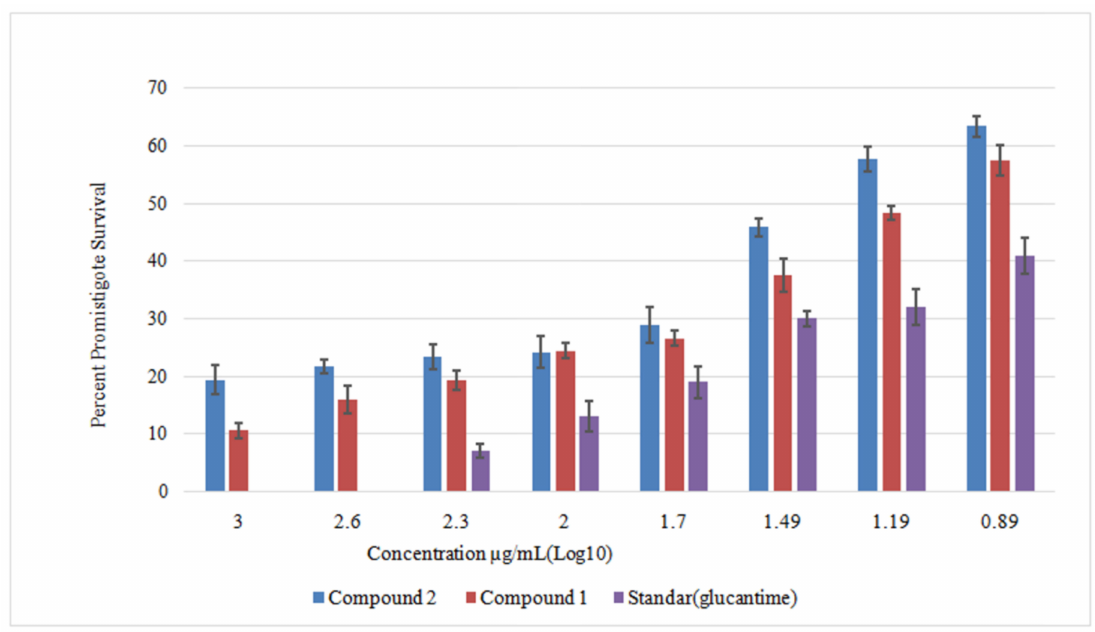
Figure 2. Anti-leishmanial potential of compound 1 and compound 2 in a dose-dependent assay, depicting promastigote survival after 72 h of treatment. Bars show significant di ff erence ( p < 0.05) in survival ratesof the parasites of respective groups. Standard drug; Glucantime LD 50 = 5.33 ± 0.07 µ g /